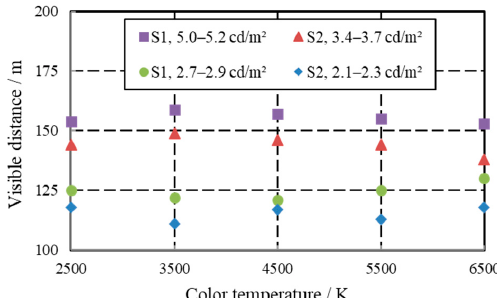
Figure 9. Visible distance for a small object in tunnel (S1 and S2 represent sidewalls with energy ‐ storage and luminescent coating and gray cloth,